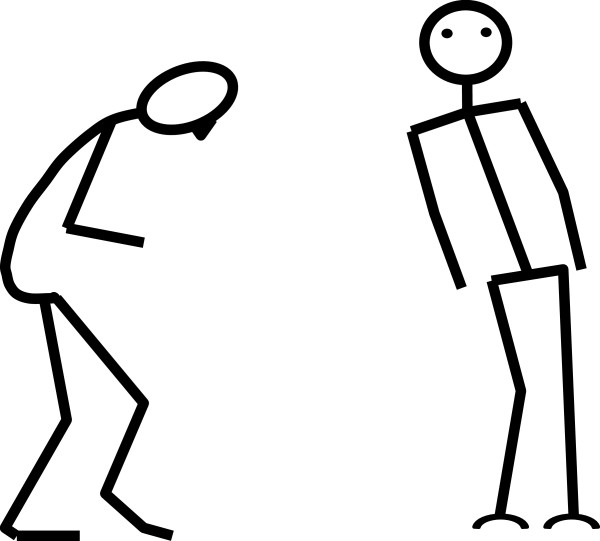
Stickmen representing postural abnormalities in parkinsonism. Simian (left), with flexion of neck, thoracic and lumbar spine, hips and knees, and hunched shoulders, is the most recognised. In coronal (right), there is lateral flexion of body and related abnormalities.